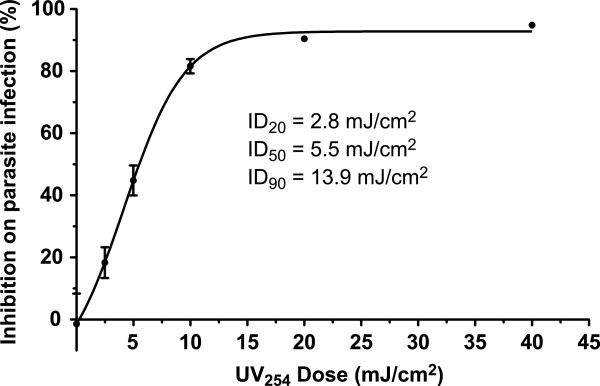
Effect of UV254 irradiation on the C. parvum oocyst viability as determined by a qRT-PCR-based in vitro infection assay. The ID20 value was determined at 2.8 mJ/cm2.